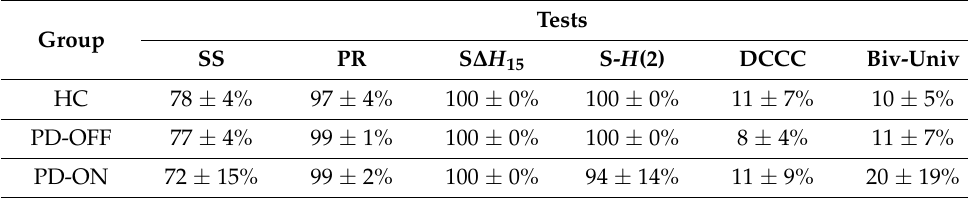
Table 1. Success rate of multifractality tests at the subject level (mean ± standard deviation). SS: spectral slope test, PR: phase randomization test, S- ∆ H 15 : ∆ H 15 part of the shuffling test, S- H (2): H (2) part of the shuffling test, DCCC: detrended cross-correlation coefficient test, Biv-Univ: bivariate- univariate H (2) comparison, HC: healthy control, PD-OFF: Parkinson’s disease patients off medication, PD-ON: Parkinson’s disease patients on medication.